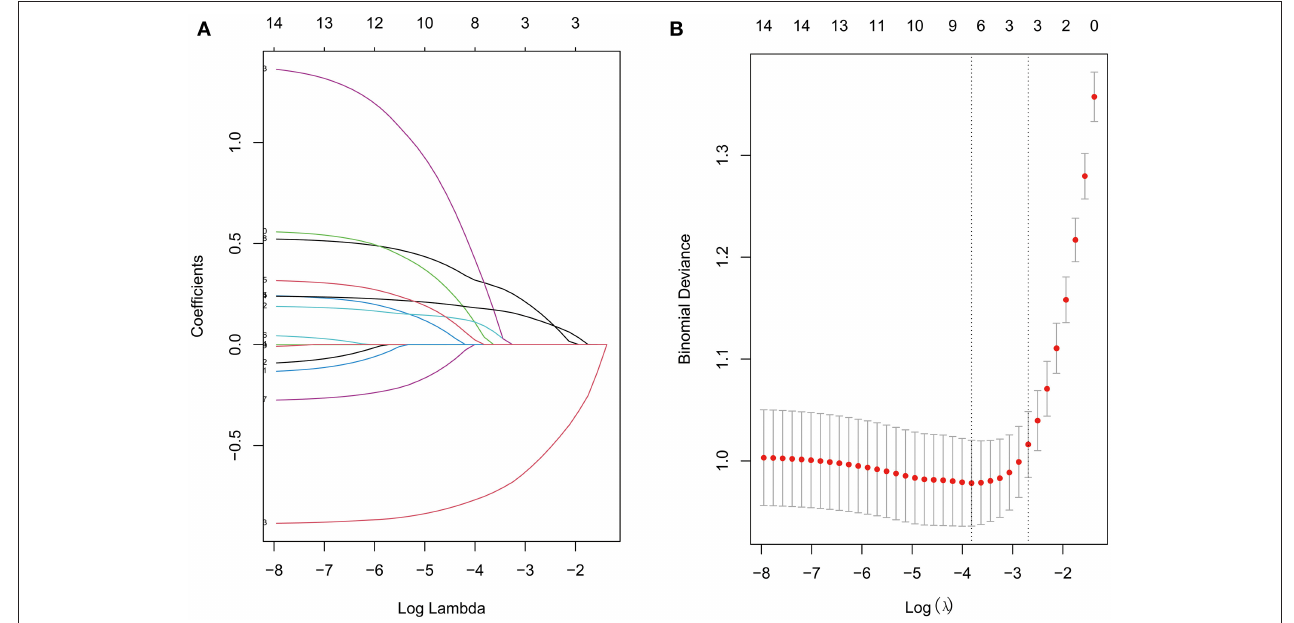
FIGURE 1 | The LASSO regression (A) Lasso coefficient profiles of 14 features. (B) Feature selection for the predictive model. Turning parameter ( λ ) selection used 10-fold cross-validation. The vertical axis shows the model misclassification rate, and the horizontal axis shows log( λ ). The two vertical dashed lines represent the minimum value and one standard deviation on one side from the minimum